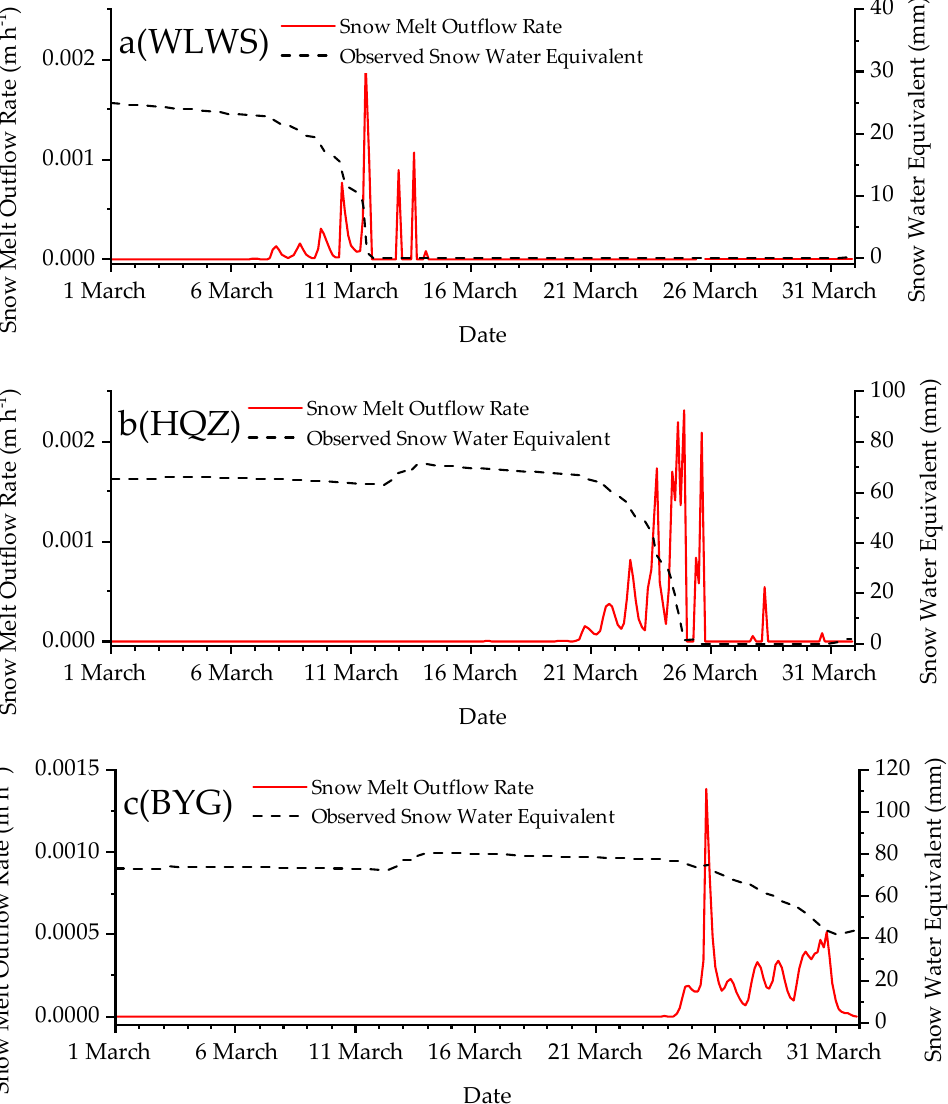
Figure 8. Trends in the simulated snowmelt outflow and SWE at 3-h intervals between 0:00 on 1 November 2014 and 21:00 on 31 March